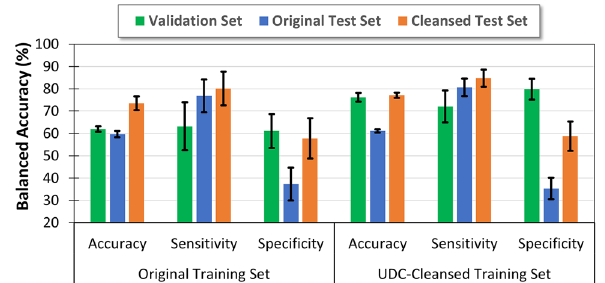
Figure 4. Performance metrics of AI model predicting clinical pregnancy, trained on original (left section) and UDC-cleansed (right section) training data. Both graphs show results on the validation set (green), and corresponding original test set (blue) and UDC-cleansed test set (orange).